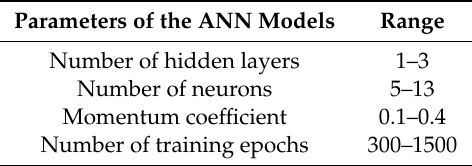
Table 5. Configurations of the artificial neural network (ANN) models.